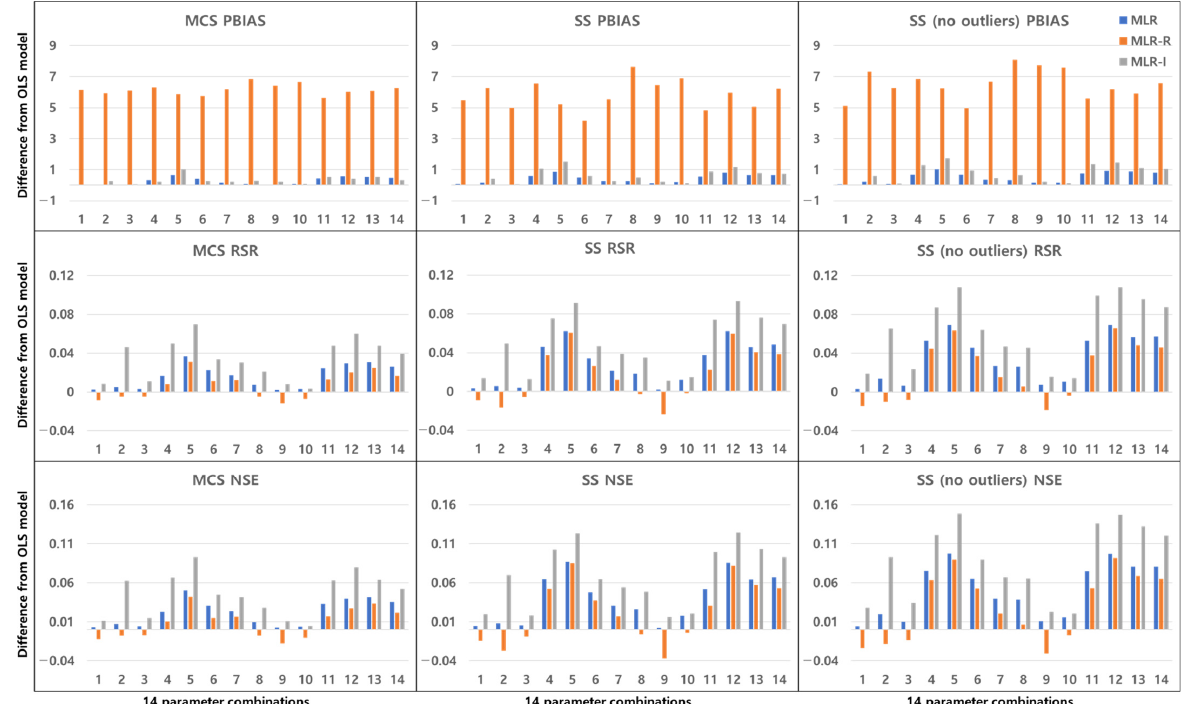
Figure 17. Differences between the OLS model and the other three MLR models by averaging the values of the model evaluations with the three sampling methods for TP removal in detention basins.